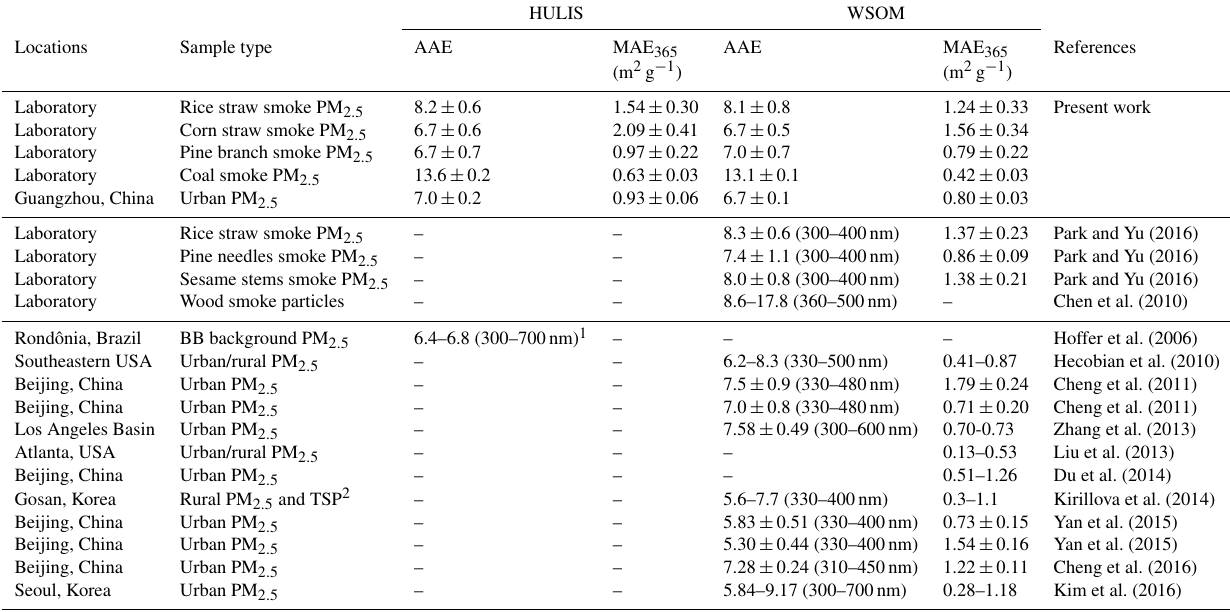
Table 7. Summary of AAE and MAE 365 of HULIS and WSOM (sometimes were inferred to water-soluble brown carbon (BrC)).